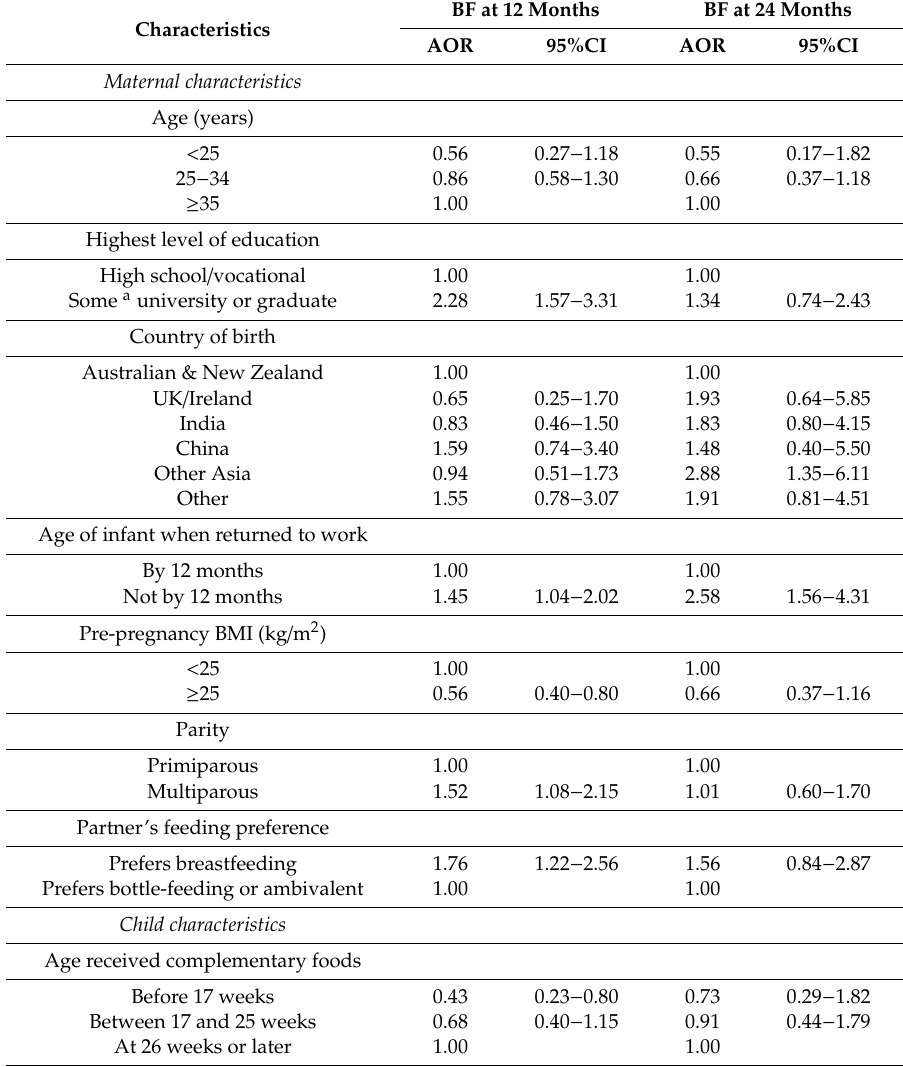
Table 4. Factors independently associated with breastfeeding at 12 months and 24 months